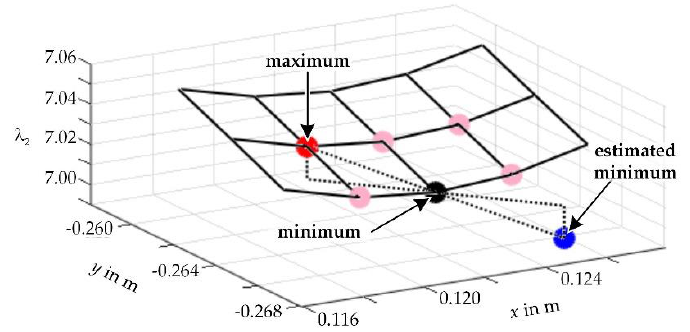
Figure 13. Estimation of a minimum λ 2 (blue) by extrapolation between the minimum (black) and the surrounding maximum (red).